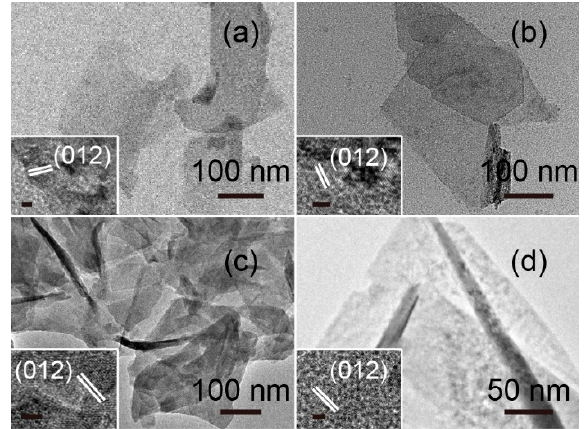
Figure 4. TEM images of ( a ) NiAl–LDH films, ( b ) NiFe–LDH films, ( c ) Fe-doped NiAl–LDH films, and ( d ) Fe-doped NiFe–LDH films. Insets are corresponding HRTEMs, scale bar: 2 nm.